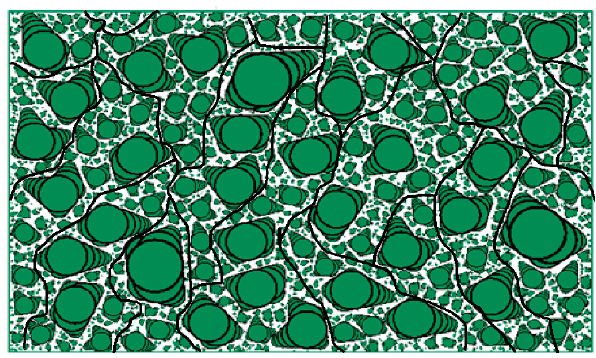
Figure 6. The model’s main interconnection gaps.